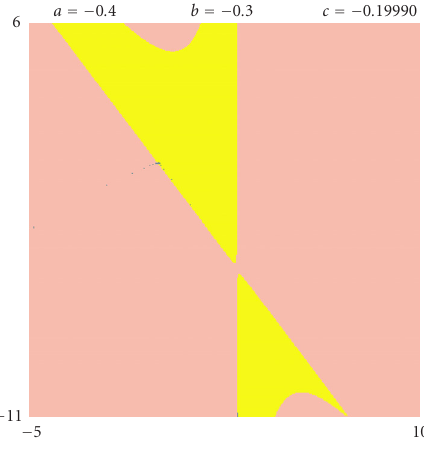
Figure 4.6. Basin nonconnected and iterates of focal point outside the basin.